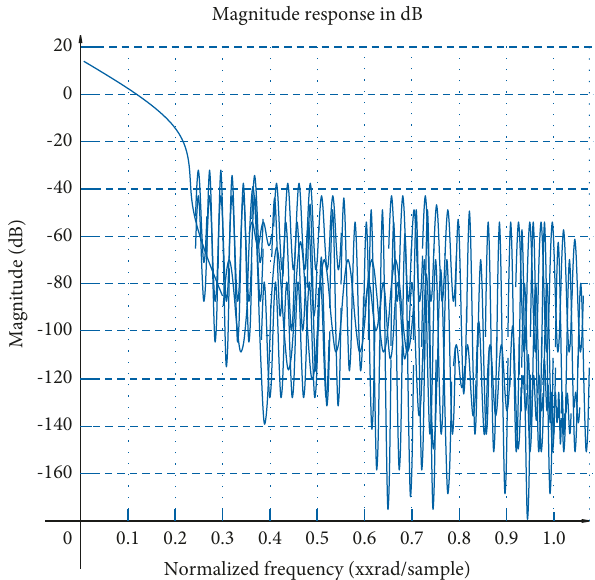
Figure 11: Frequency response of FIR low-pass filter with a normalized cutoff frequency 0 . 125 π .